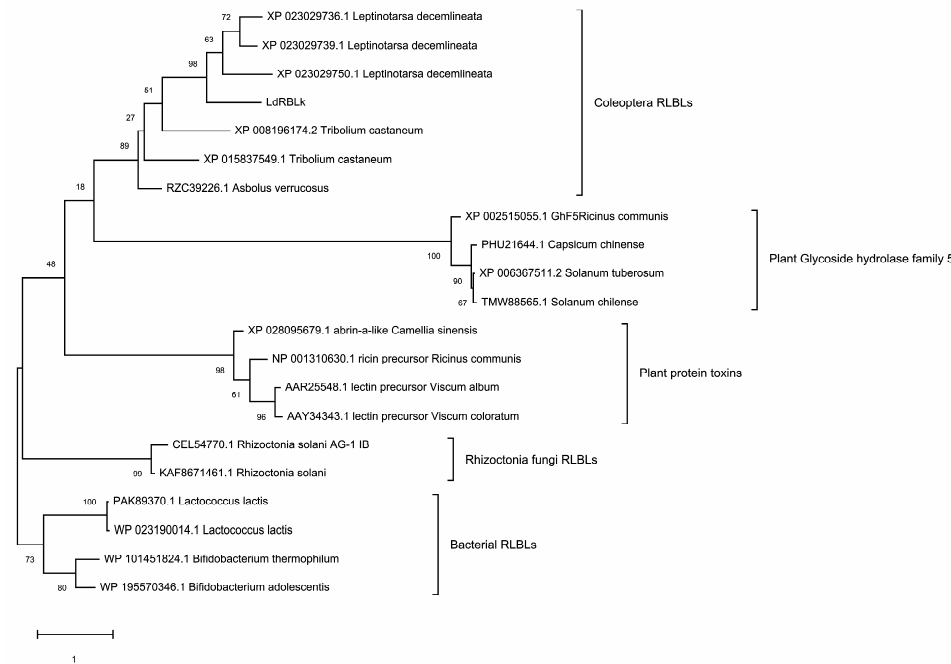
Figure 3. Evolutionary relationships of RBLs sequences from L. decemlineata and other Coleoptera, plant glycoside hydrolase family 5, plant protein toxins, R. solani fungi and bacteria inferred by using the Maximum Likelihood method and Whelan and Goldman + Freq. model [47]. The tree with the highest log likelihood ( − 9927.80) is shown. The percentage of trees in which the associated taxa clustered together is shown next to the branches. A discrete Gamma distribution was used to model evolutionary rate differences among sites (5 categories (+ G, parameter = 10.2324)). The tree is drawn to scale, with branch lengths being measured as the number of substitutions per site.